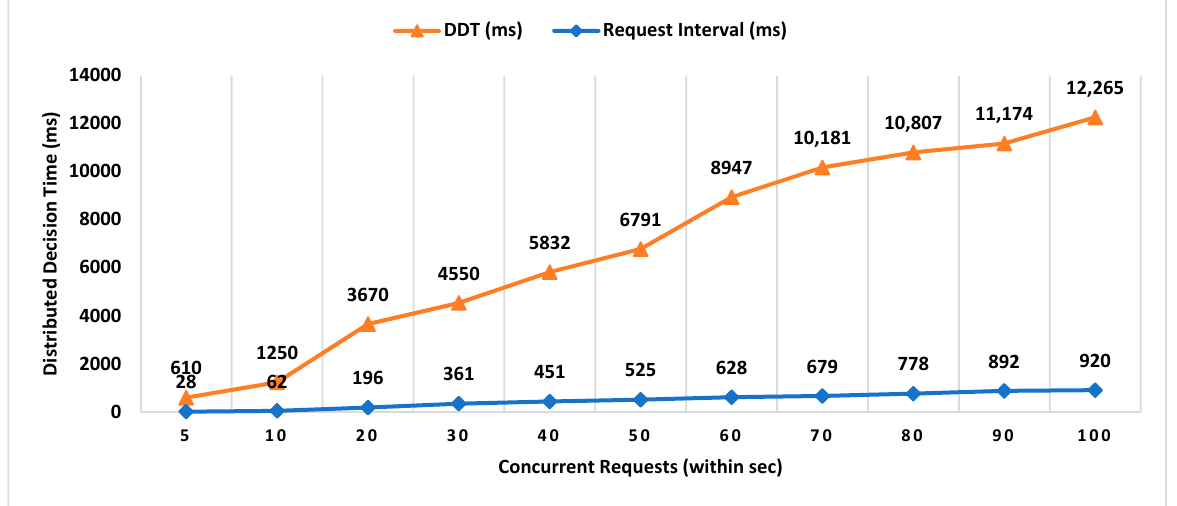
Figure 12. Concurrent request impact on decentralized decision time.